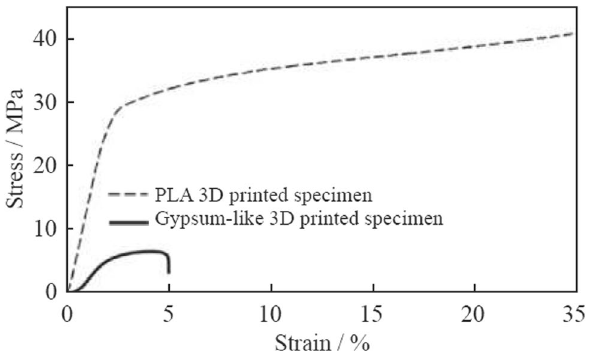
Fig. 7 A comparison of the stress–strain curve of the 3DP PLA sam- ple with the 3DP gypsum sample (Jiang and Zhao 2015)